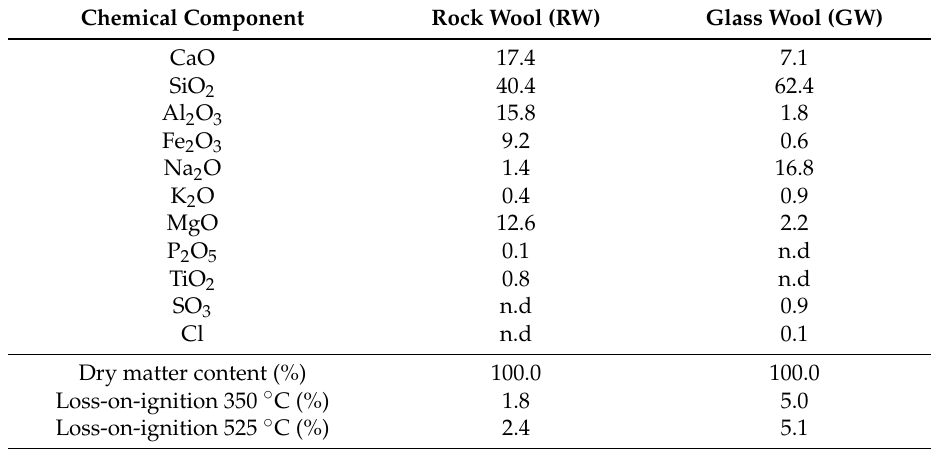
Table 1. The chemical composition, dry matter content, and loss-on-ignition of rock wool (RW) and glass wool (GW), determined by XRF and